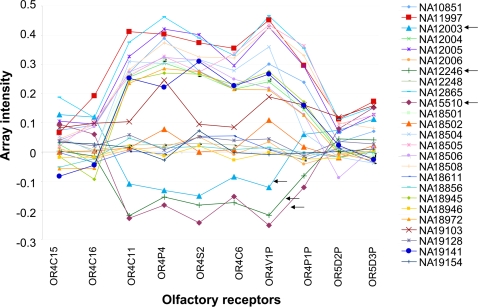
Zoom into a bi-allelic CNV affecting OR4C11.Plot depicting median normalized log2-ratios of microarray intensities for OR loci affected by deletion I (chr11: 55127497–55238834), a bi-allelic CNV. Each individual is color-coded as indicated in the legend shown to the right. Black arrows indicate samples that consistently failed to produce results in the qPCR and standard PCR assays, indicating a potential homozygous deletion.